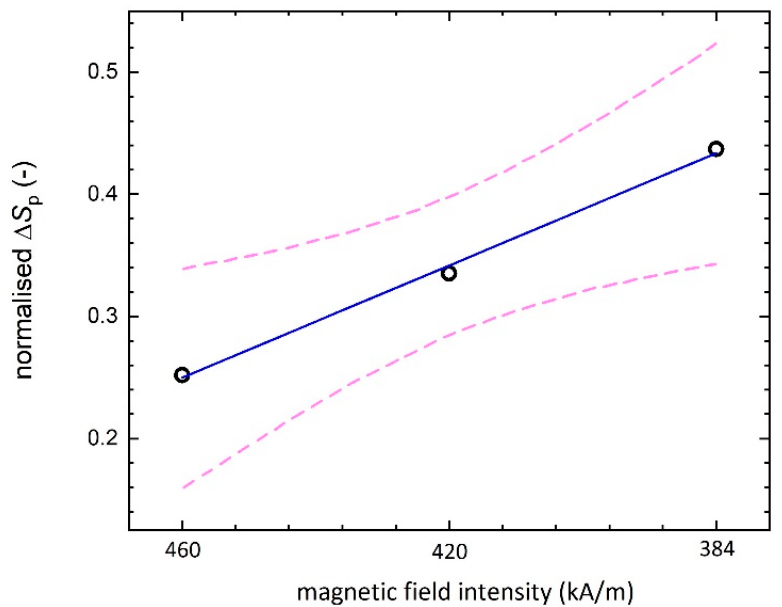
Figure 7. Polishing efficiency versus magnetic field applied; linear regression (full blue line) and its 95% confidence interval (dotted pink lines) are marked.